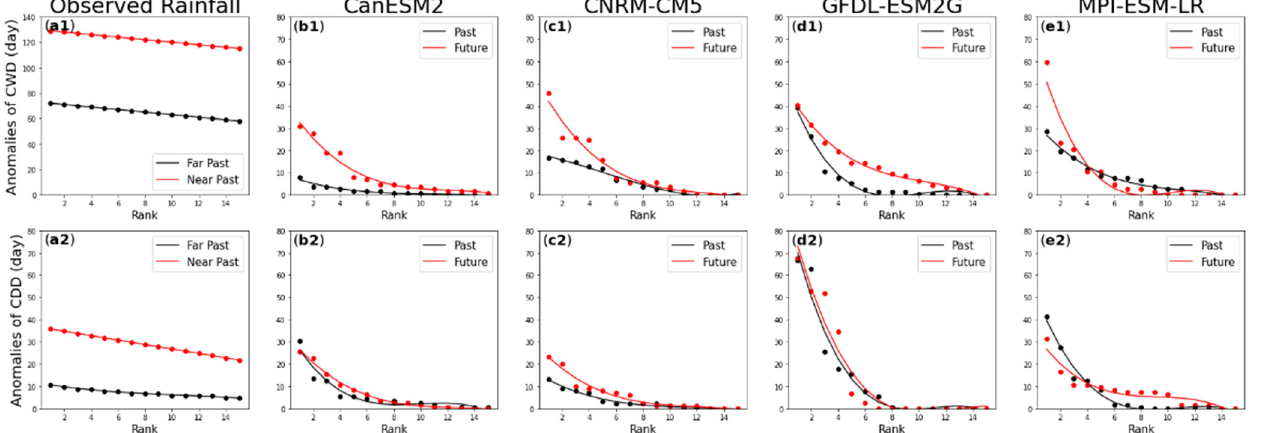
Figure 8. Anomalies of CWD and CDD of observed far past (1976–1996) and near past (1997–2017) rainfall and the past and future rainfall of the selected models: Observed Rainfall ( a1 , 2 ), CanESM2 ( b1 , 2 ), CNRM-CM5 ( c1 , 2 ), GFDL-ESM2G ( d1 , 2 ), MPI-ESM-LR ( e1 , 2 ).